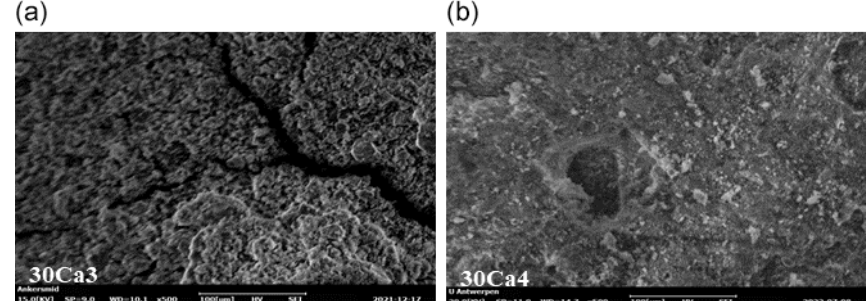
Figure 2. (a) SEM-BSE image of sample 30Ca3, (b) SEM-BSE image of sample